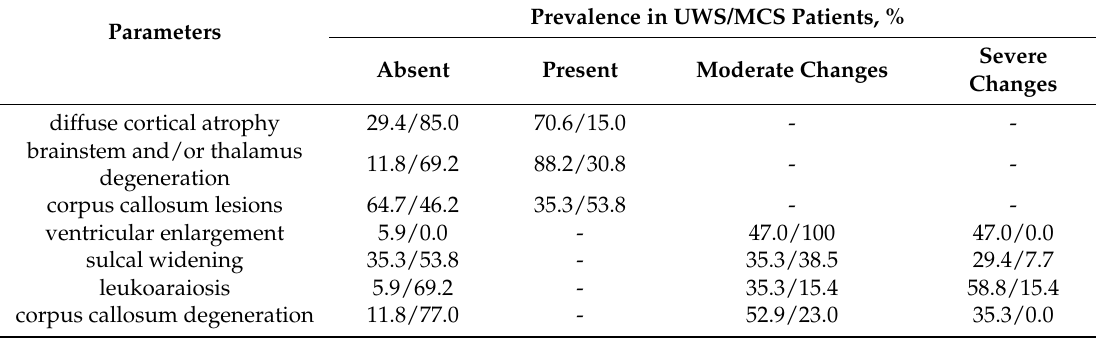
Table 3. Prevalence of DOC-MRIDS-assessed parameters in UWS and MCS